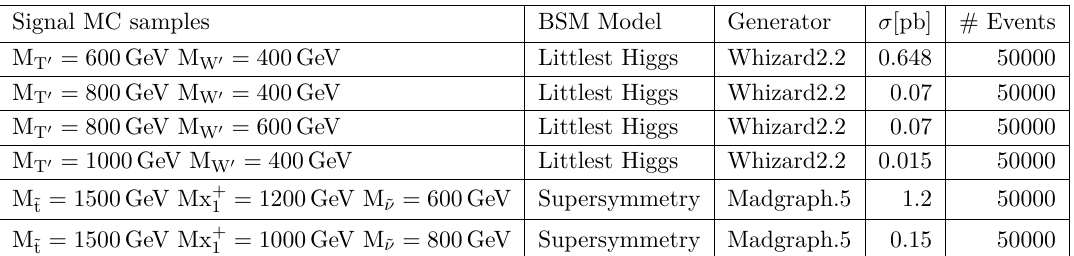
Table 2 . Simulated samples of the BSM signals with their corresponding cross section and produced event